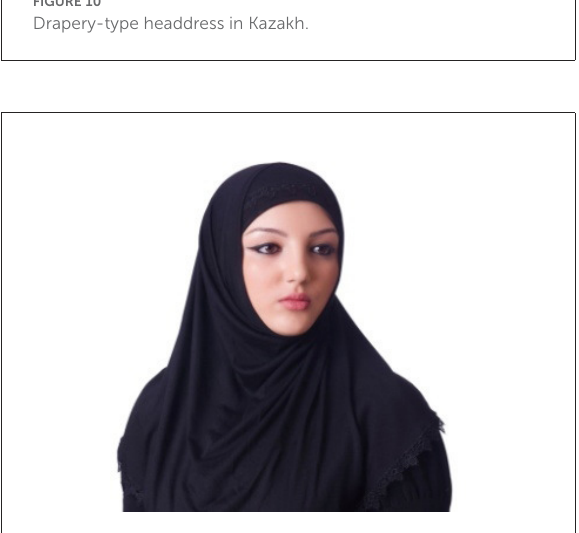
FIGURE10 Drapery-type headdress in Kazakh.